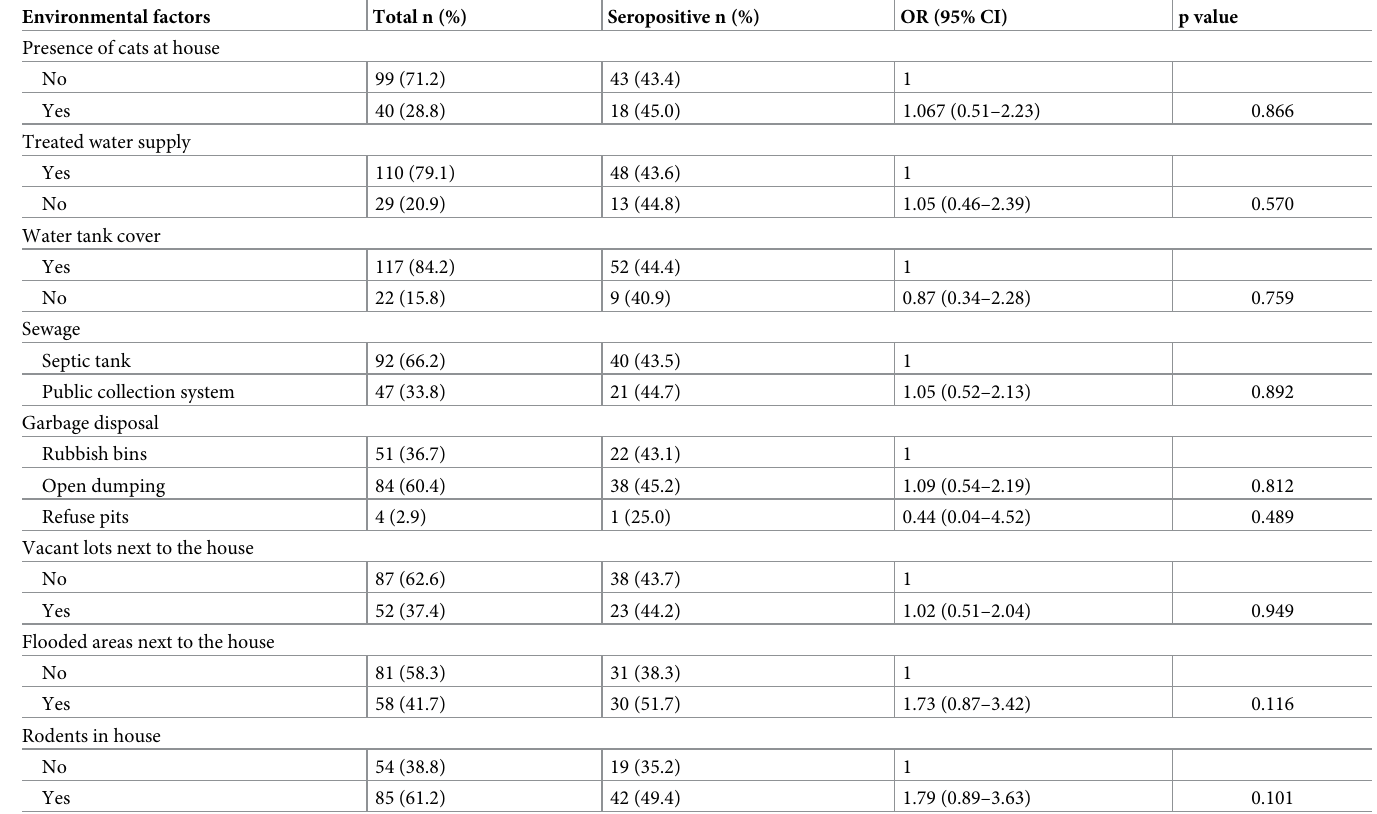
Table 4. Environmental factors associated with seropositivity of Toxoplasma gondii among slaughterhouse workers. Environmental